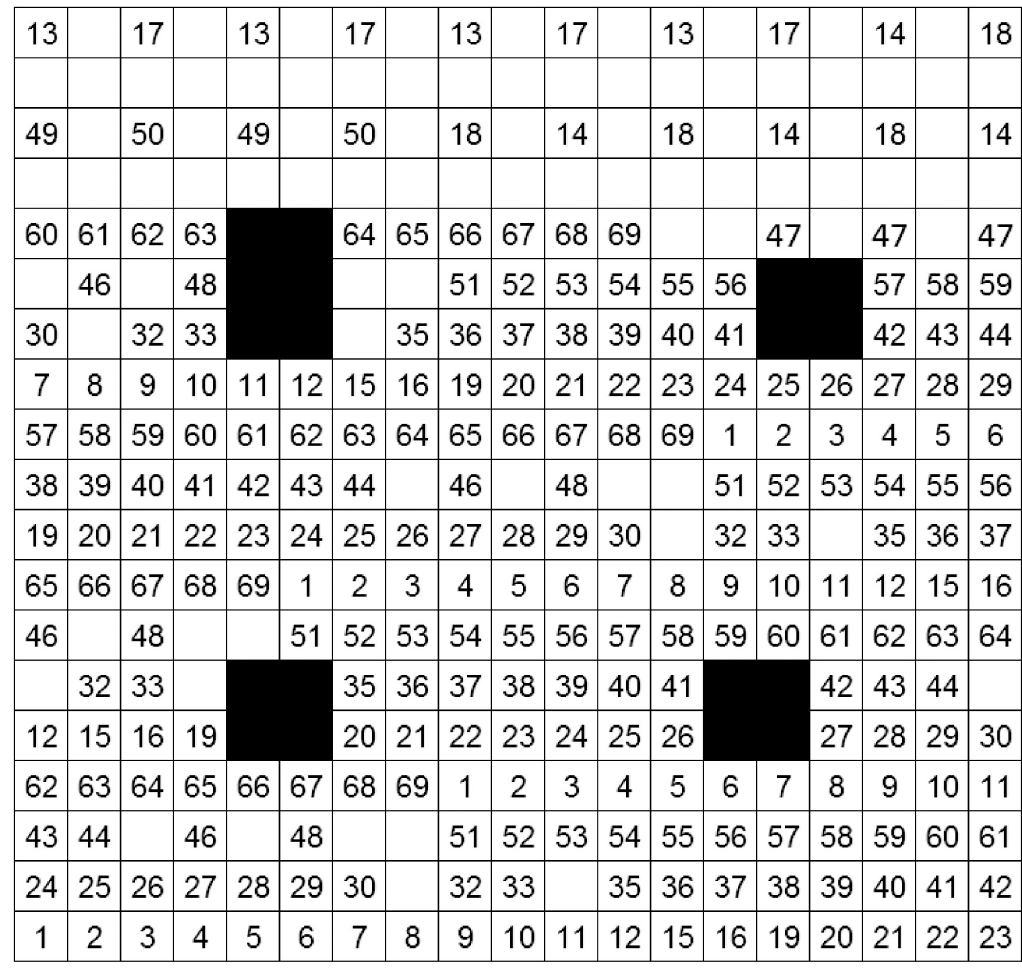
Fig 1. Layout of the produced microarray chip. Antigens were spotted in different concentrations ( μ g/ μ L). Black squares are metal marks and are necessary for image analysis. 1–3 : Hepatitis E virus ( 1 = 0.75, 2 = 0.5, 3 = 0.25); 4–6 : M . avium ( 4 = 0.23, 5 = 0.1, 6 = 0.05); 7–9 : Y . enterocolitica mix ( 7 = 0.3, 8 = 0.2, 9 = 0.1); 10–12 : Influenza A virus ( 10 = 0.2, 11 = 0.1, 12 = 0.05); 13–16 : PRRSV ELISA mix ( 13 = 0.75, 14 = 0.5, 15 = 0.2, 16 = 0.1); 17–20 : PRRSV in-house mix ( 17 = 0.75, 18 = 0.5, 19 =